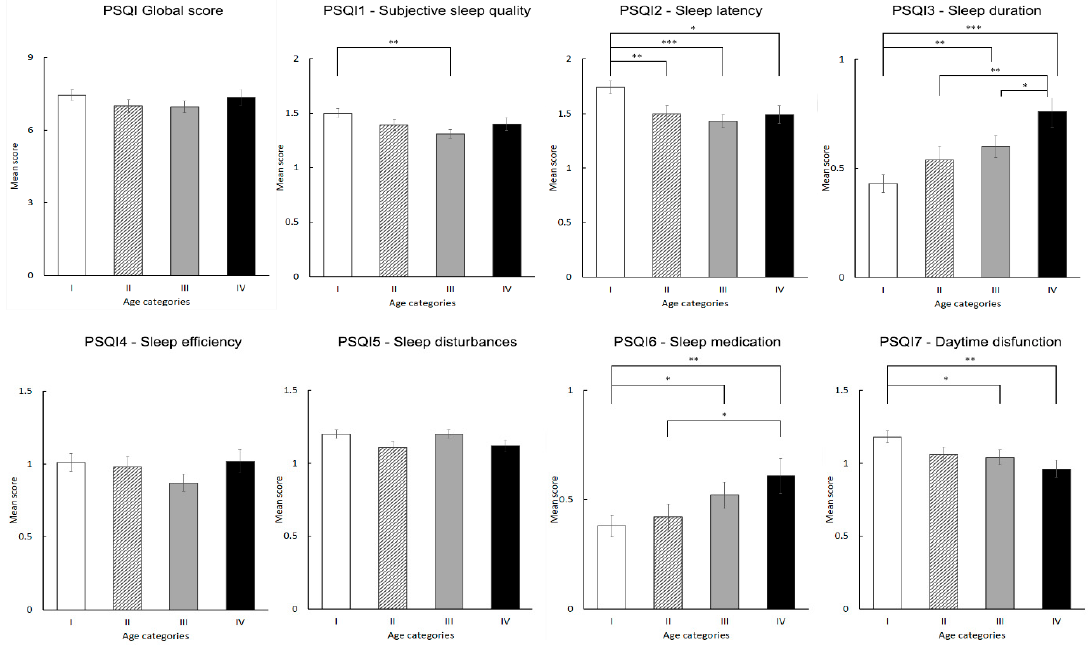
Figure 1. Pittsburg sleep quality index (PSQI) global and component scores according to age